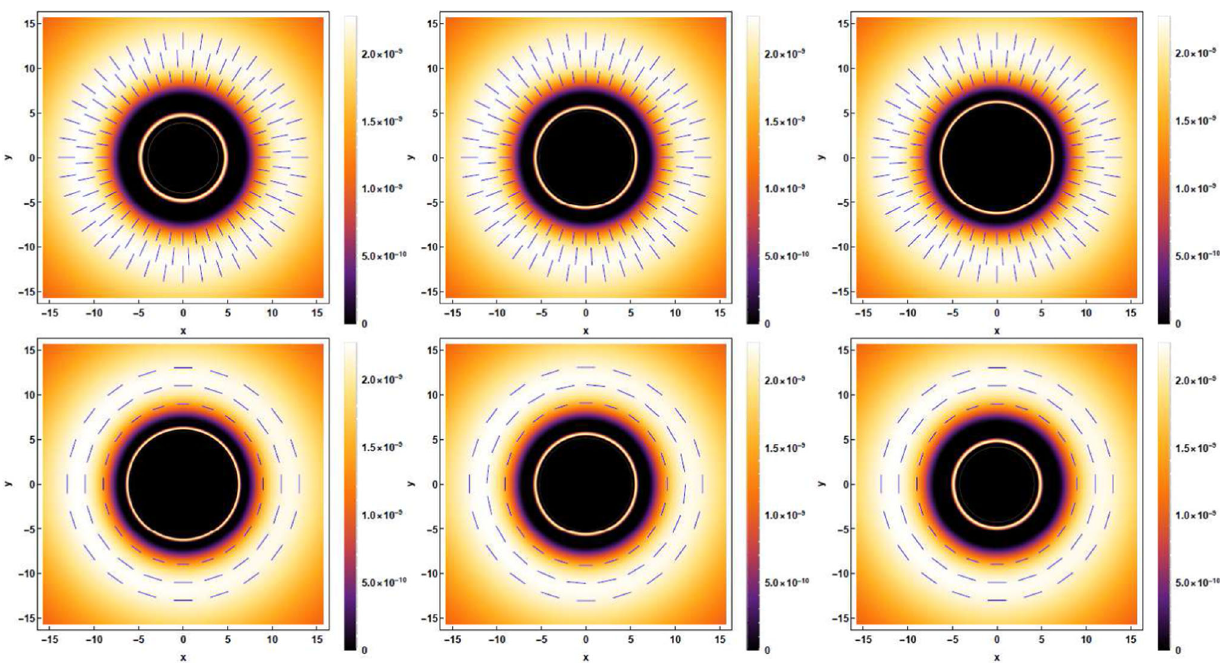
Fig. 6 Polarized intensity tick plots in the direct image for the fixed θ o = 0 ◦ . The upper row is for the PPL and the bottom row is for the PPM. In each row, the coupling parameter α in three panels from left to right is set to − 0 . 4, 0, and 0 . 4, respectively. Here, we set M = 1